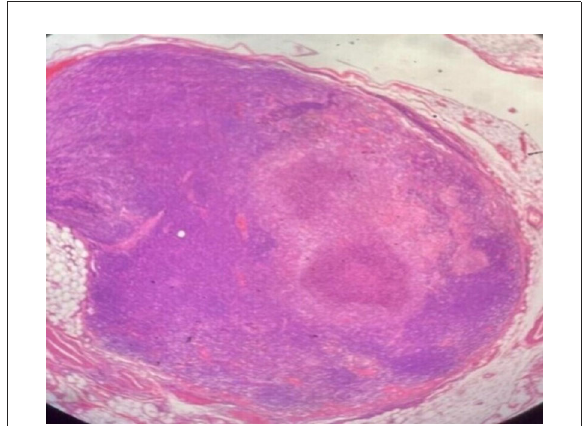
FIGURE1 Section examined reveals lymph node showing areas of necrosis and abscess surrounded by palisading histiocytes along with capsular and subcapsular